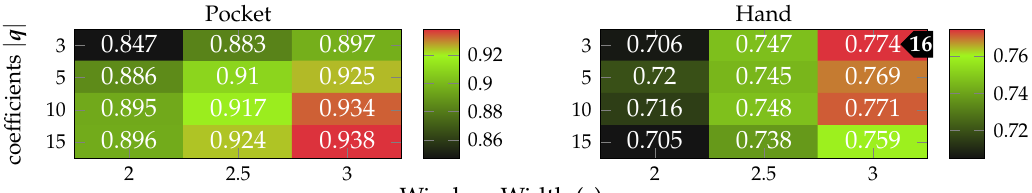
Figure 23. Resulting classification accuracies for the approach based on statistical features, when only using AR-Coefficients at different hyperparameter configurations, shown as a function of the model order | q | and the used window length for both pocket-case and